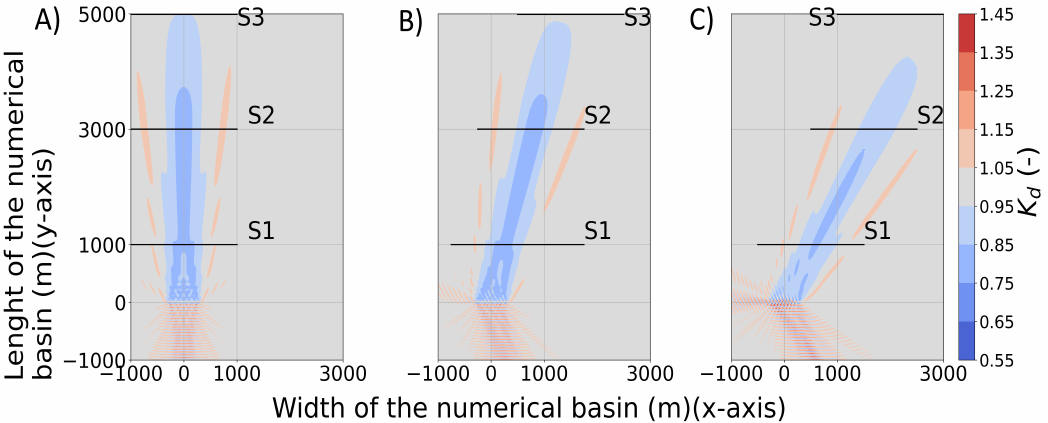
Figure 6. K d disturbance coefficient results for a 21 HPA WEC farm interacting with regular waves of H = 2.0 m, T = 8 s and ( A ) θ = 0 ◦ , ( B ) 15 ◦ and ( C ) 30 ◦ in the MILDwave-NEMOH coupled model. S1, S2 and S3 indicate the locations of the cross-sections. Contour levels are set at an interval of 0.05 for the K d value. The water depth is 30 m. Waves are generated along the bottom boundary.